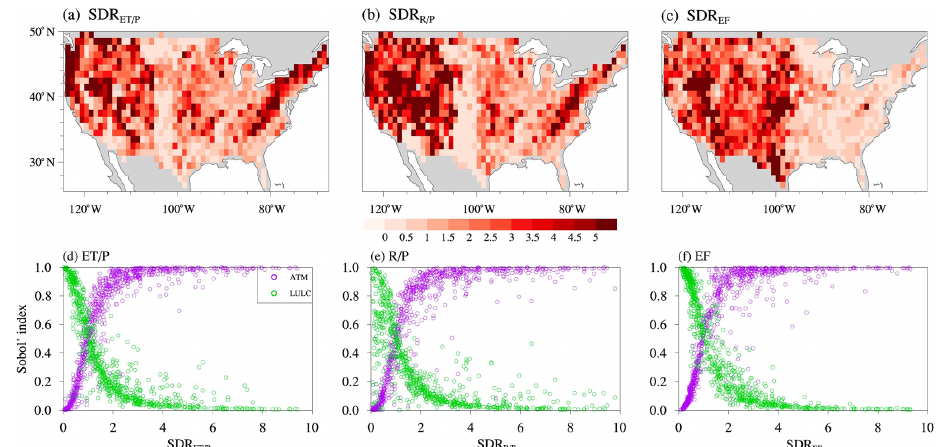
Figure B1. Spatial patterns of SD ratios (a–c) and their spatial relationship with the ATM and LULC Sobol’ total sensitivity index (d–f) for ET /P , R/P and EF, respectively. The y axis values correspond to the spatial patterns of the Sobol’ total sensitivity index for ATM (purple) and LULC (green) in Fig. 5 (i.e., each circle corresponds to each 1 ◦ × 1 ◦ region).